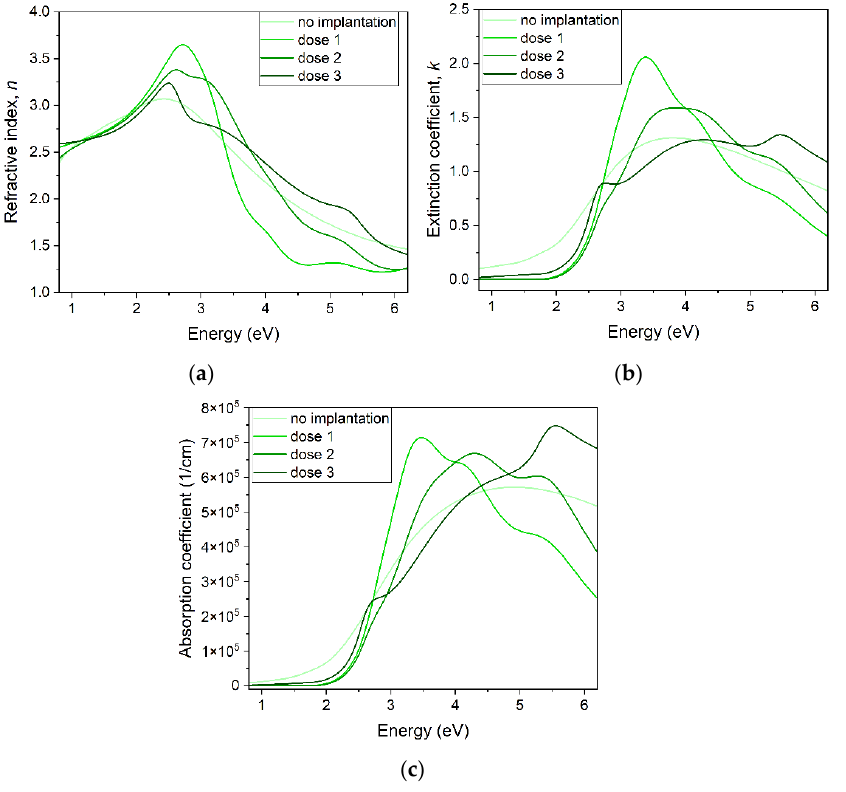
Figure 7. Optical properties of Cu 2 O samples calculated from ellipsometric model fitting: ( a ) refractive index n , ( b ) extinction coefficient k , ( c ) absorption coefficient α .